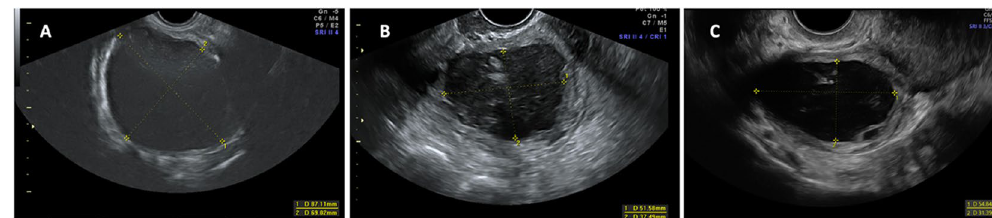
Figure 3. Sonographic evolution of ovarian endometrioma at baseline and at 12 and 24 months of follow-up. ( A ) Large endometrioma with a mean size of 78.0 mm which decreased to 44.5 mm at the 12-month follow-up in image ( B ) and to 43.1 mm at the 24-month follow-up in image ( C ).